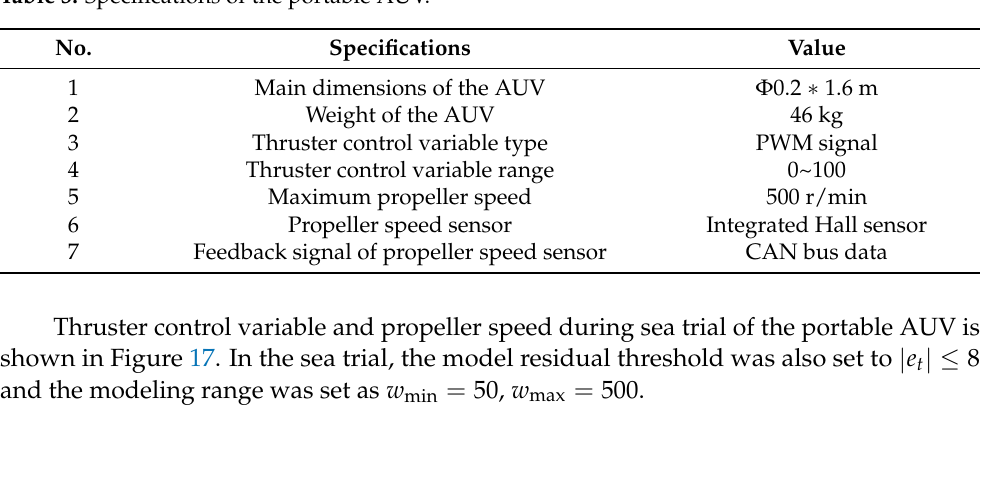
Figure 17. Thruster control variable and propeller speed of the portable AUV. During the sea trial, the thruster system worked in a fault-free state initially, the port- able AUV sailing in shallow sea water. Near the 2400th sampling period, the AUV en- counters weeds, some weeds are caught in the propeller, causing minor failures of the